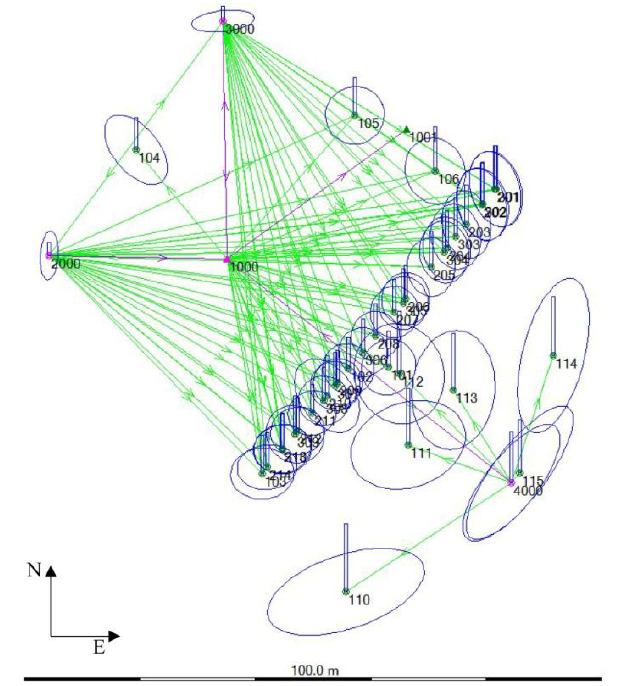
Figure 13. The October 2011 topographic network georeferenced in UTM-ETRF2000 RS. The magnification factor of the error ellipses compared with the network is equal to